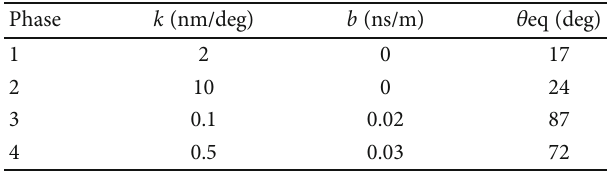
Table 4: Coe ffi cient of controller for stair ascent.